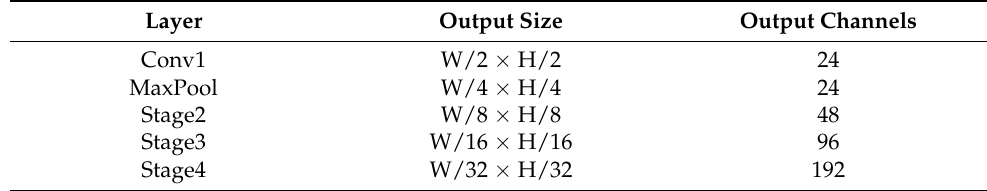
Table 3. The output feature map size and number of channels of each layer of ShuffleNetv2. Layer